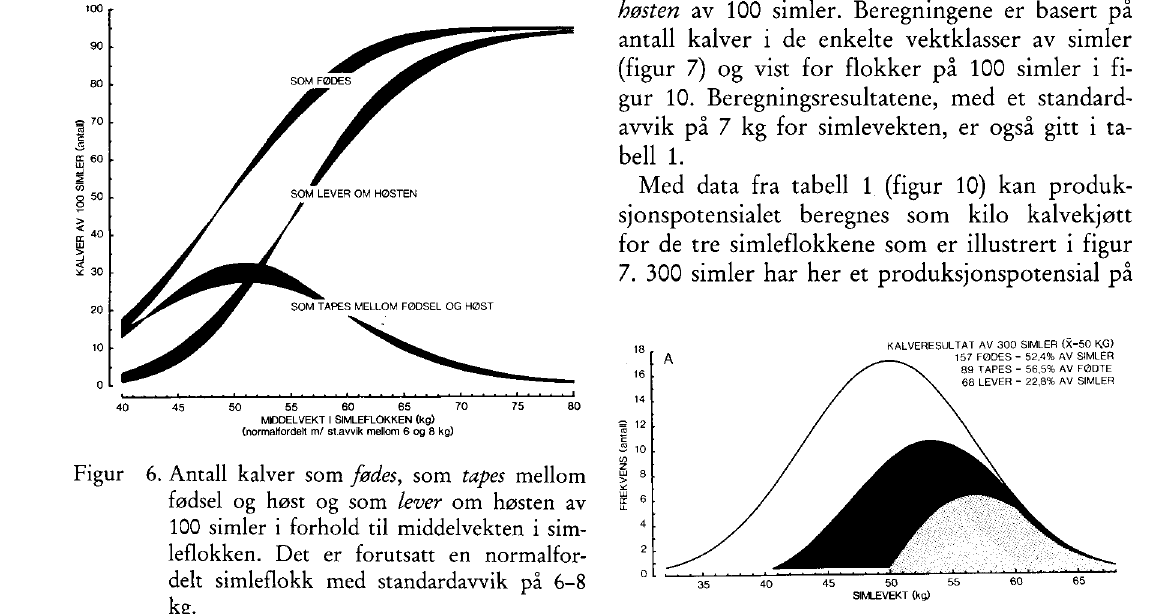
Figur 6. Antall kalver som fødes, som tapes mellom fødsel og høst og som lever om høsten av 100 simler i forhold til middelvekten i sim- leflokken. Det er forutsatt en normalfor delt simleflokk med standardavvik på 6-8 kg.